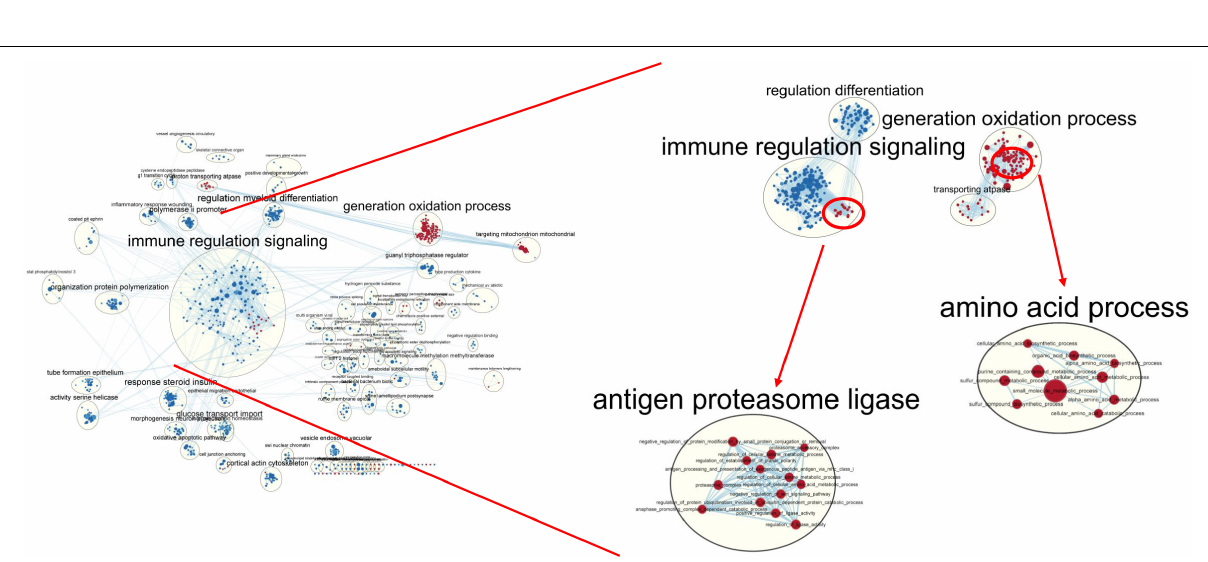
Frontiers in Genetics |